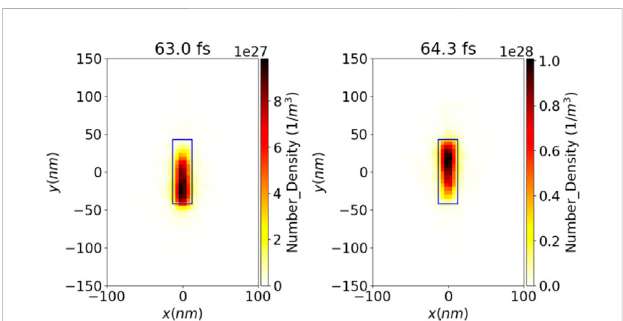
FIGURE 1 (color online) Cross section of the 25 nm (diameter) × 85 nm nanorod showing number density of electrons at the tips, leaving the nanorod at different times t , half of the light wave time period apart. The number of electron marker-particles inside the simulation box will decrease with a signi fi cant amount by the end of simulation at 120 fs. Light travels fromleftto rightinthe x direction,thepolarizationof lightis aligned with the nanorod ’ s orientation in y direction.